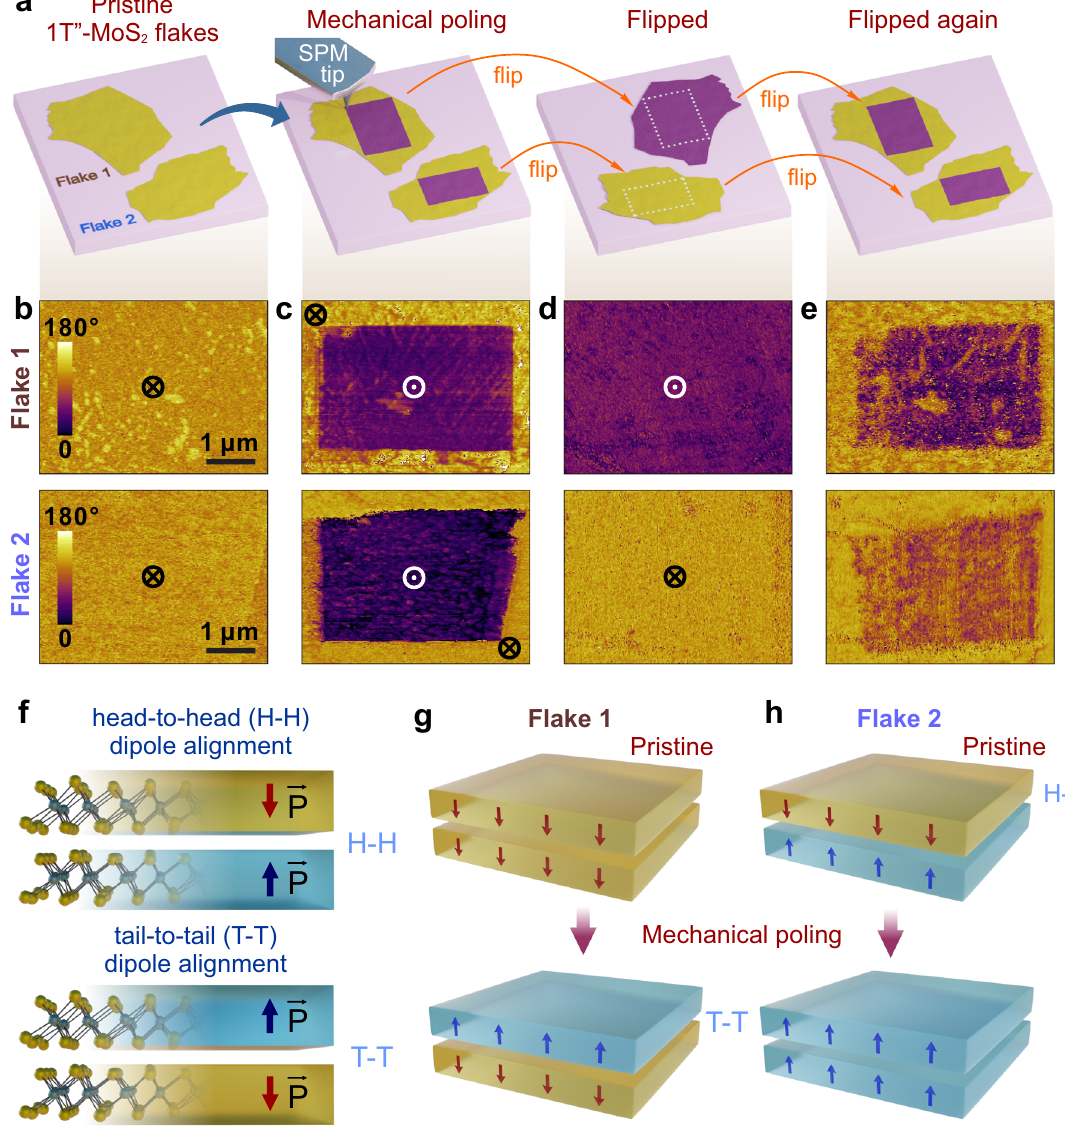
Fig. 4 Observation of the PFM signals in the fl ipped 1T ” -MoS 2 fl akes. a Scheme of the experiment that involves mechanical poling and fl akes with downward polarization. c PFM phase images of the fl ipping of the fl akes. b PFM phase images of two pristine 8-nm-thick 1T ” -MoS 2 same fl akes after application of a mechanical load of 1100 nN to their central regions resulting in the switching to the upward polarization state. d PFM phase images of the same fl akes after they were fl ipped over and placed on the same substrate. The entire fl ake #1 exhibits the upward polarization, while the entire fl ake #2 exhibits the downward polarization. e PFM phase images of the same fl akes after they were fl ipped back to their original orientation. f Illustrations of the antipolar H-H and T-T dipole alignments. g , h Schemes of the dipole alignments in fl akes #1 and #2 in their pristine state and after mechanical poling corresponding to the experimental results shown in b – e